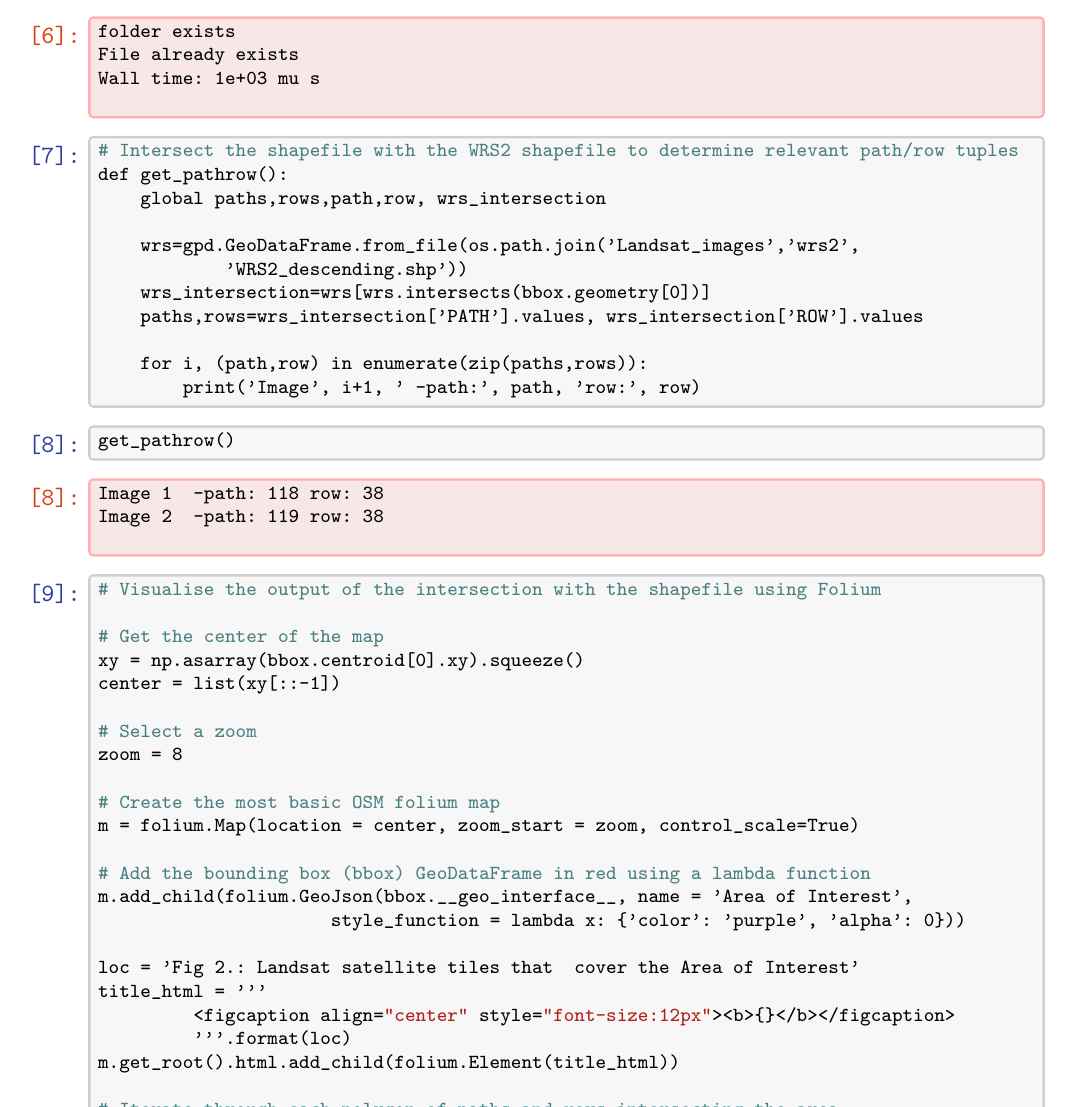
loc = ’Fig 2.: Landsat satellite tiles that cover the Area of Interest’ title_html = ’’’ <figcaption align="center" style="font-size:12px"><b>{}</b></figcaption>